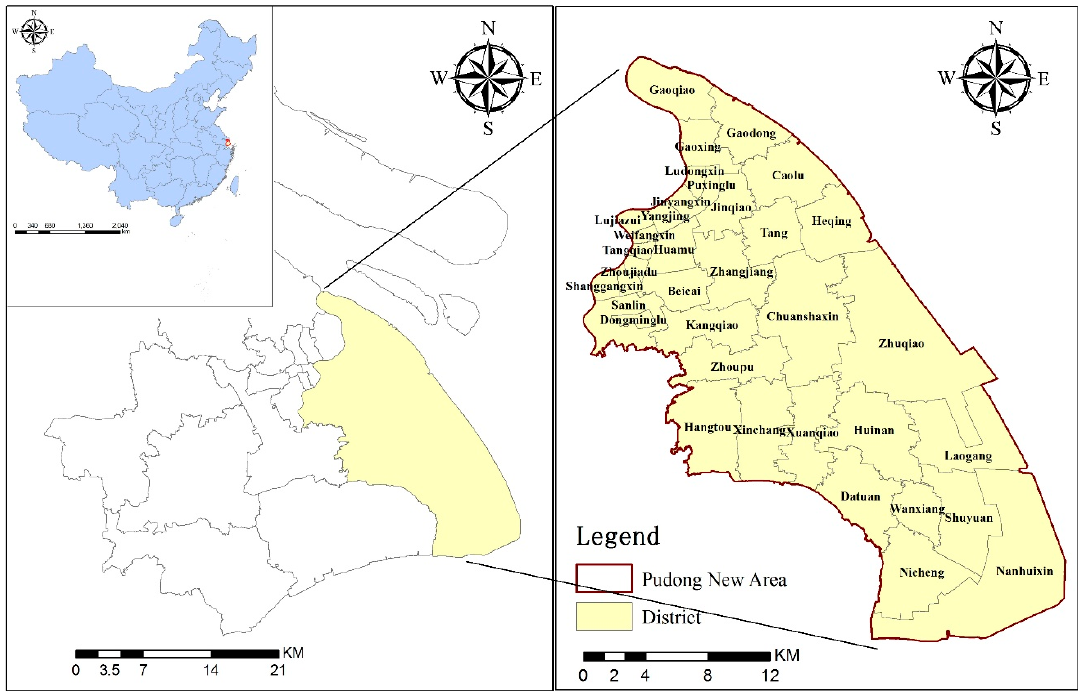
Figure 1. Regional location of the Pudong New Area (PNA) of Shanghai.